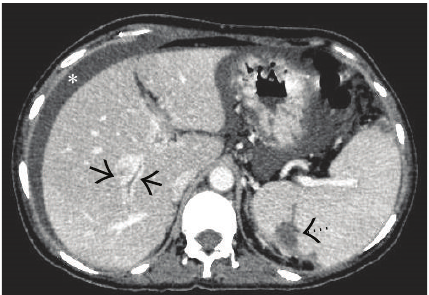
Figure 48: Axial CECT image of a patient with EHPVO showing multiple tiny paracholedochal collaterals appearing as continuous enhancement of one of the biliary radicals in right hepatic lobe (arrows) mimicking cholangiocarcinoma (pseudocholangiocarci- noma sign). Splenic infarct is also seen due to associated splenic vein thrombosis (interrupted arrow) along with ascites